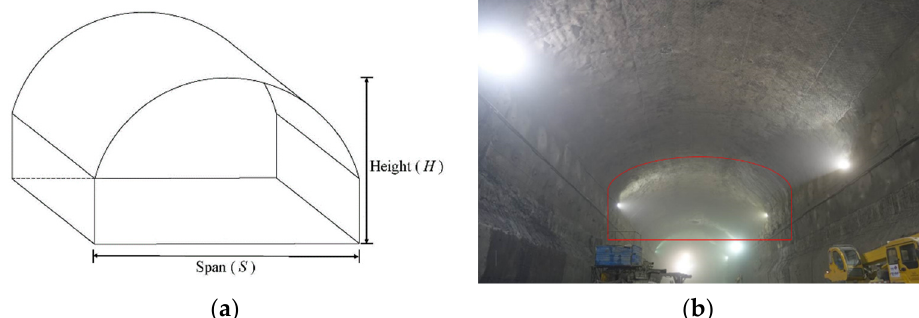
Figure 8. Top arch zone of an underground powerhouse. ( a ) The excavation diagram of the top arch zone. ( b ) The engineering scene of the top arch zone.